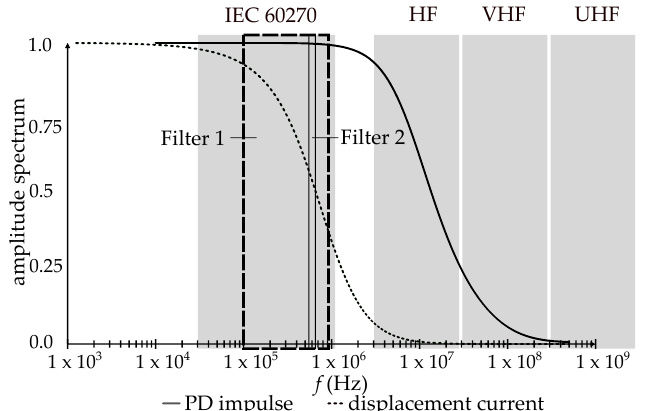
Figure 1. Amplitude spectrum of the displacement current in a solid insulation and of a PD impulse, as well as the ranges for PD measurements according to